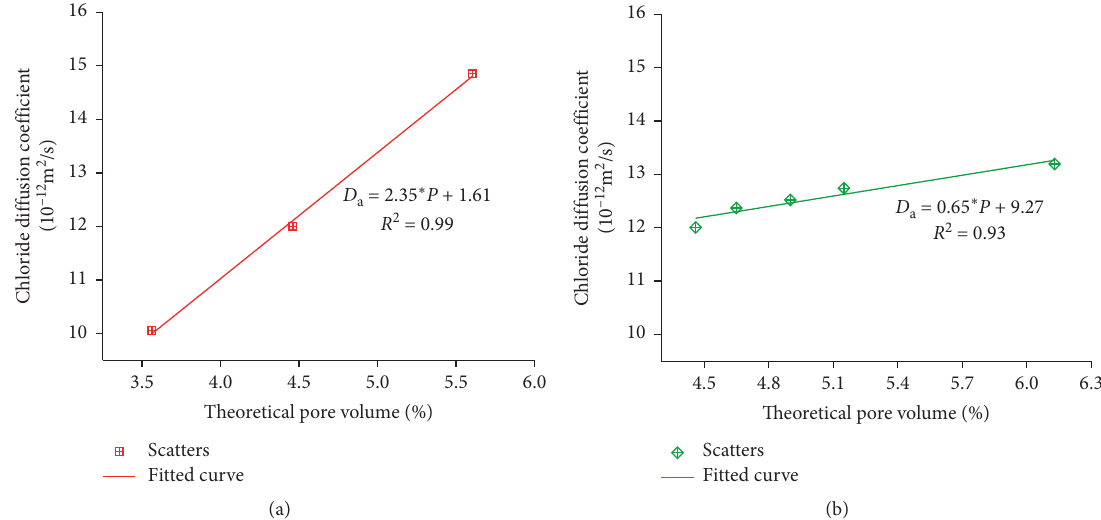
Figure 15: Relationship between theoretical pore volume and (D) types and